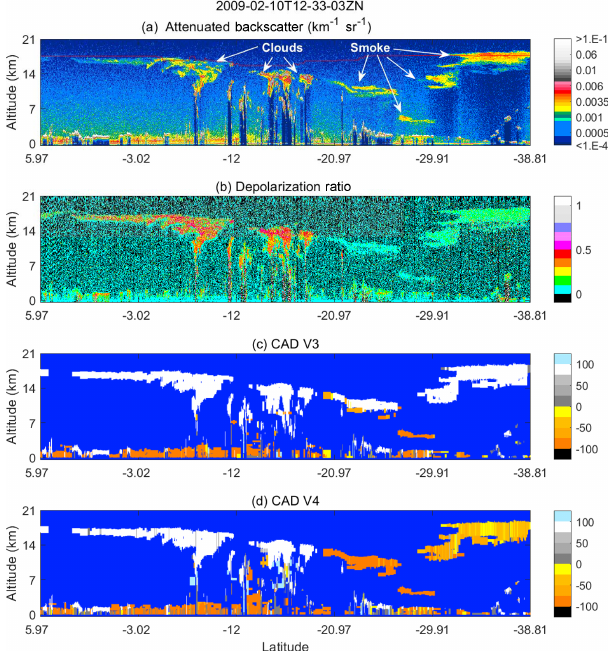
Figure 14. (a) V4 532nm attenuated backscatter coefficients, (b) 532nm volume depolarization ratios, (c) version 3 CAD scores, and (d) version 4 CAD scores for the granule 2009-02-10T12-33- 03ZN between 5.97 ◦ N and 38.81 ◦